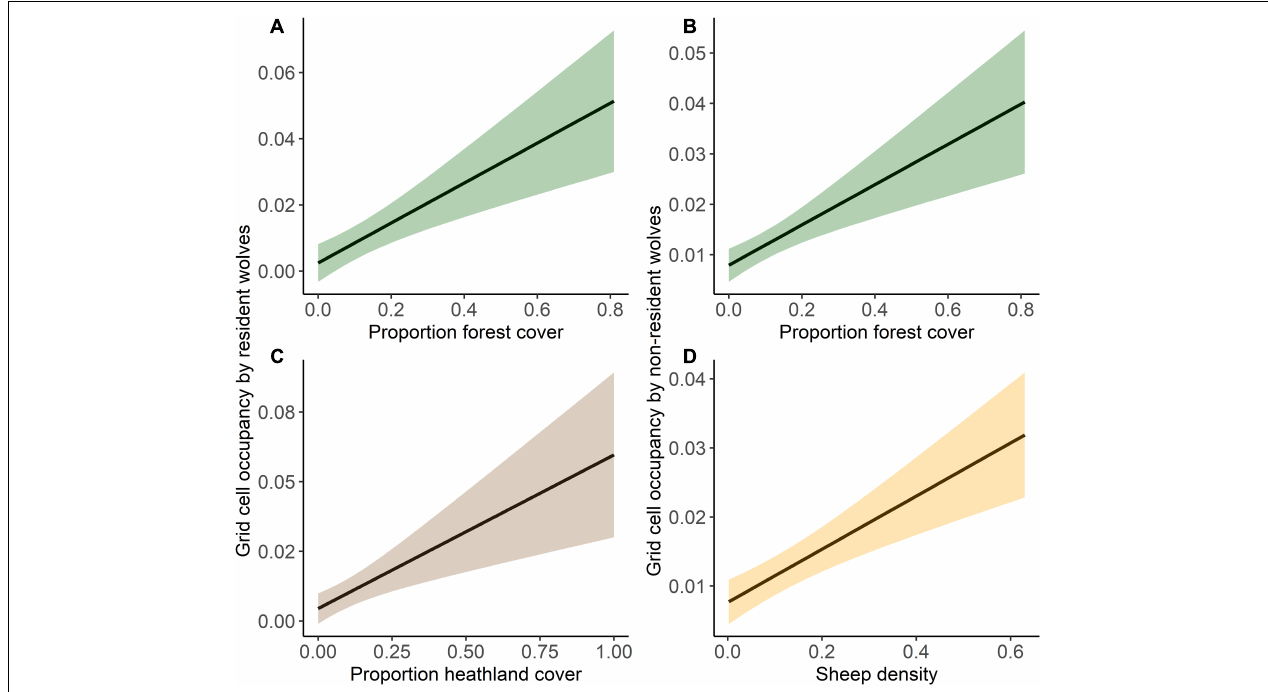
FIGURE 2 | Predicted grid cell occupancy by resident wolves (left panel) in relation to (A) forest cover, and (C) heathland cover, and by non-resident wolves (right panel) in relation to (B) forest cover, and (D) sheep density. 95% confidence intervals are given as shading.